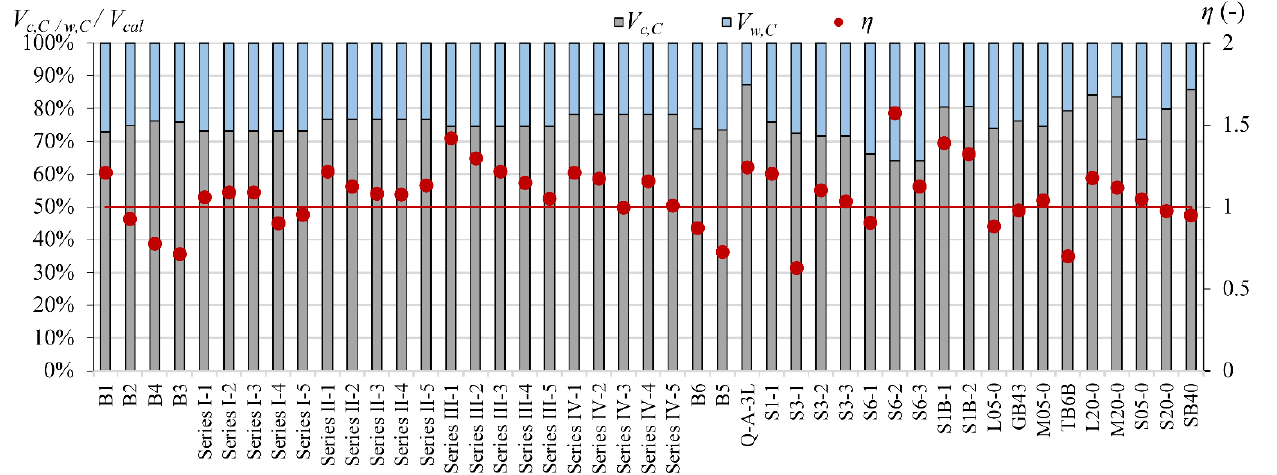
Figure 7. The comparison of shear mechanism contribution according to the Cladera et al. model for rectangular beams (red line indicated η = 1).